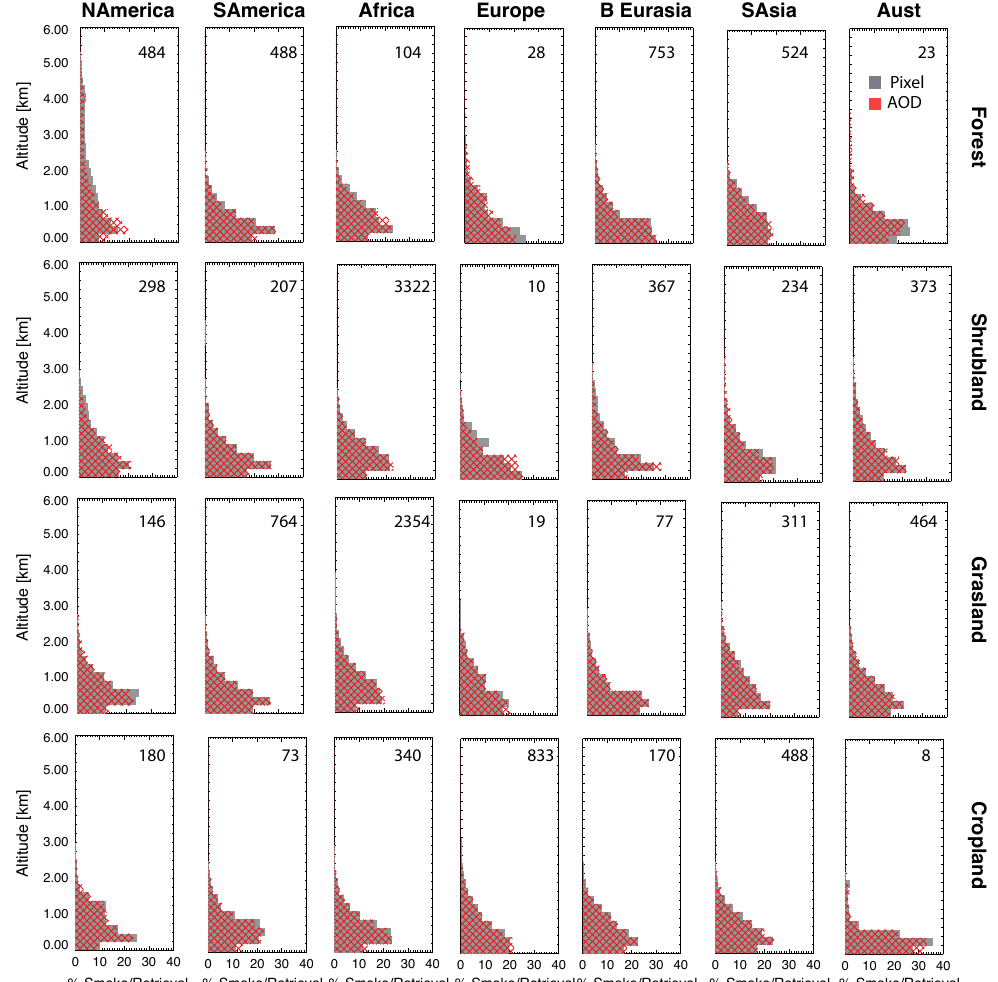
Figure 8. Vertical distribution of percentage of pixel-weighted (grey) and AOD-weighted (hatched red) stereo-height retrievals in 250-m bins. Profiles show the stereo-height retrievals pixel-filled and AOD-filled and adjusted by the GFED4s to account small fires. Numeric annotations indicate the number of plumes in each